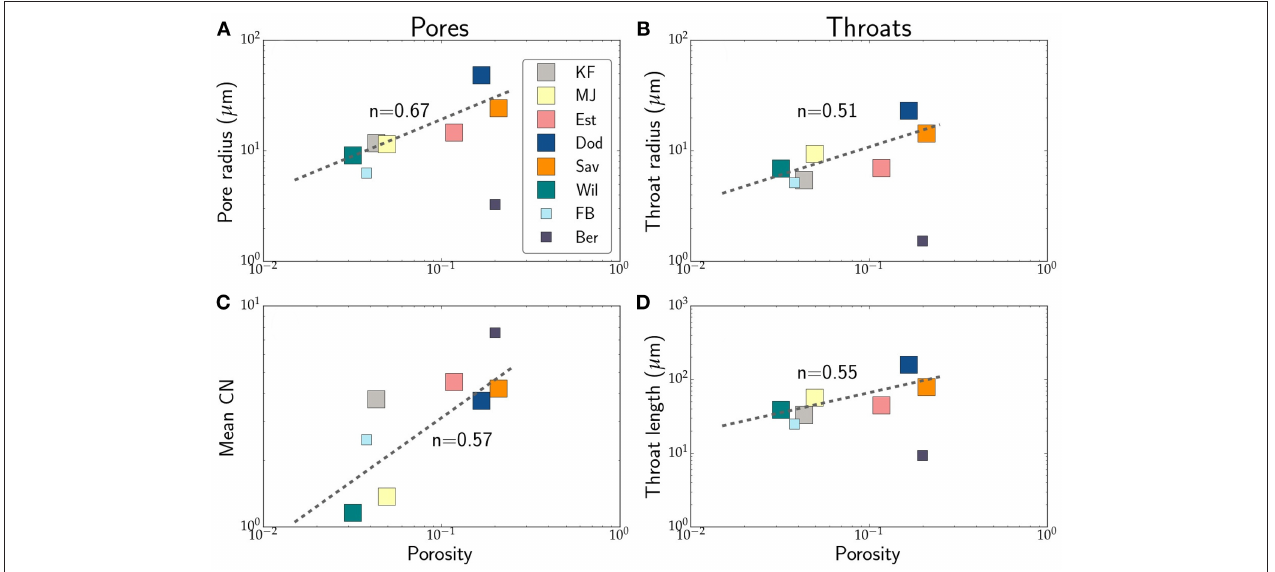
FIGURE 6 | Macropore network characteristics of the six samples from this study (KF, Knorringfjellet; Wil, Wilcox; Dod, Doddington; MJ, Massangis Jaune; Sav, Savonnières; Est, Estaillades) and 2 samples (FB, Fontainebleau; Ber, Berea) from Thomson et al. (2018). The panels display log-log plots of (A) pore radius, (B) throat radius, (C) mean coordination number, and (D) throat length as a function of macroporosity. The broken line indicates a power law fit through the six data points from this study. The power law exponent for each fit is annotated in the plot. The two samples with smaller symbol size are from higher resolution images with smaller voxel